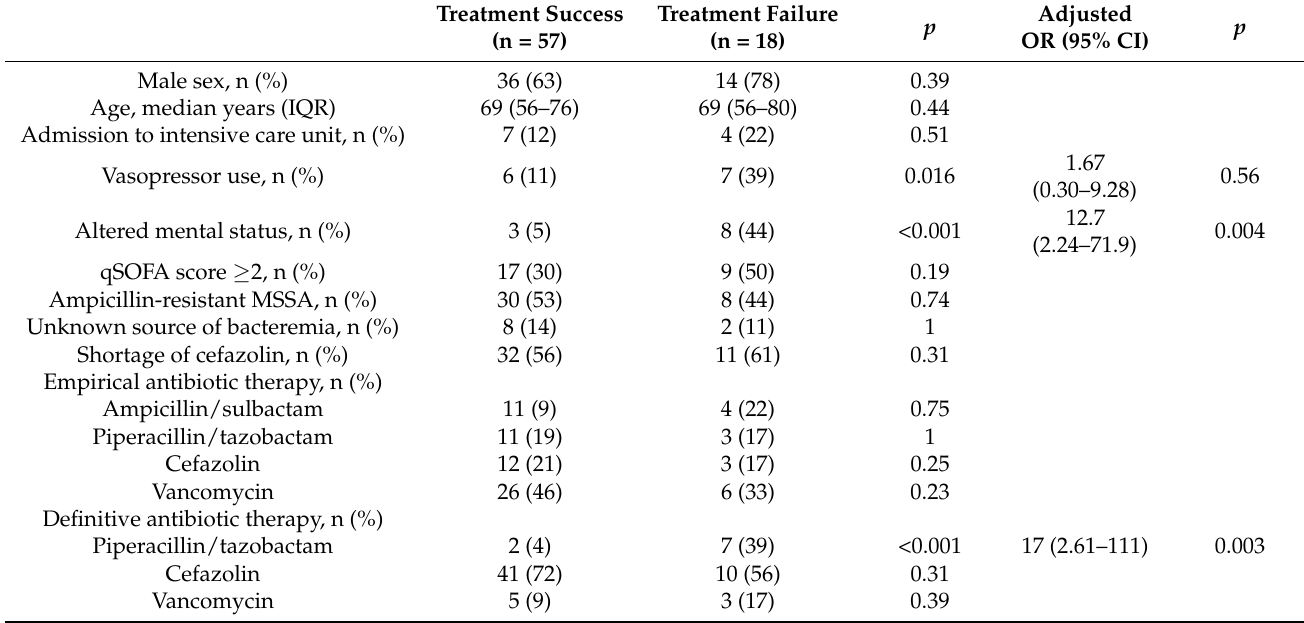
Table 3. Factors associated with treatment failure for MSSA